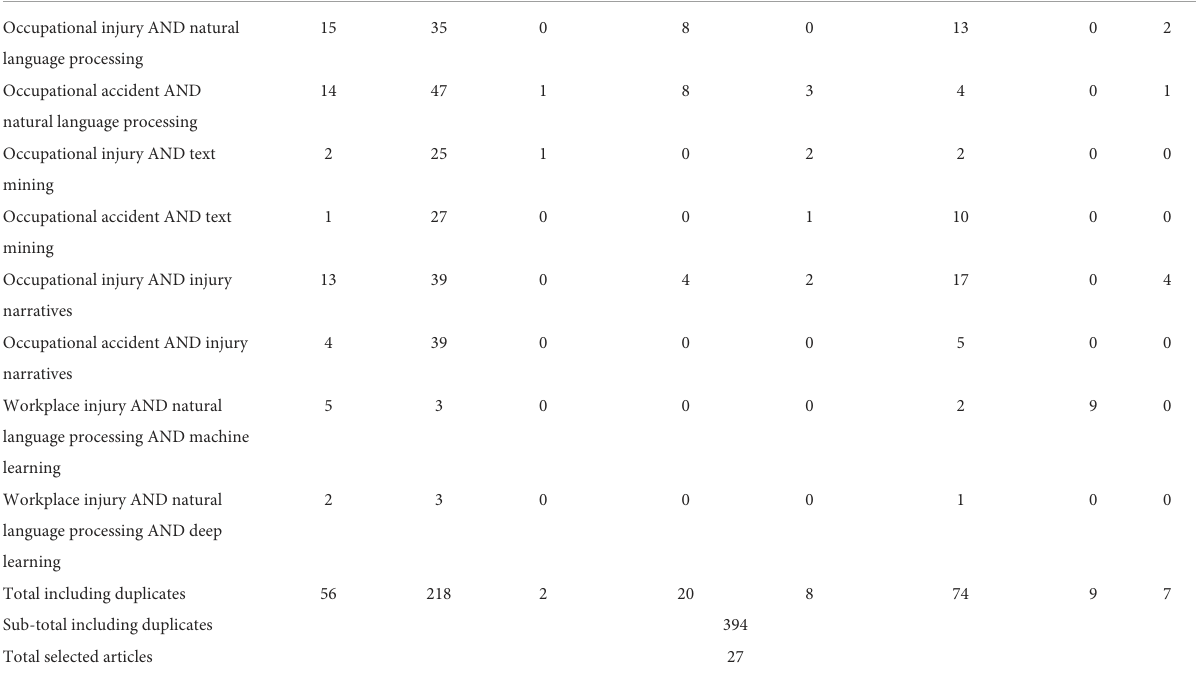
TABLE 2 Search strings for eight